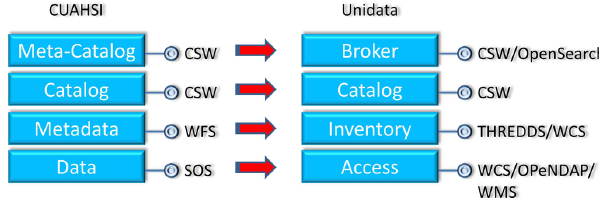
Fig. 10. Correspondences between existing services in the CUAHSI-HIS and Unidata